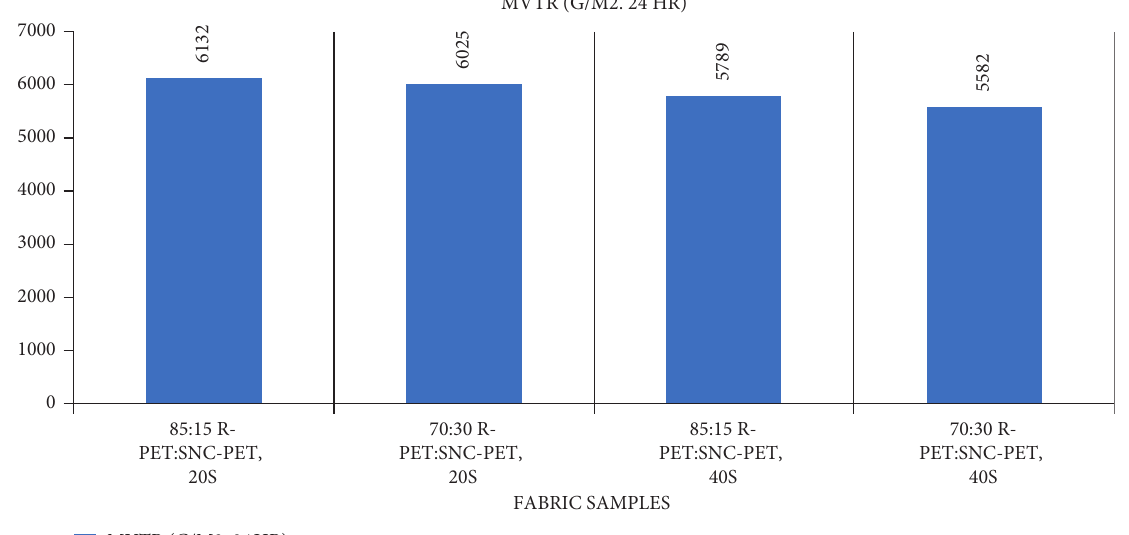
Figure 11: MVTR (g/m2. 24hr) of the woven fabric samples.